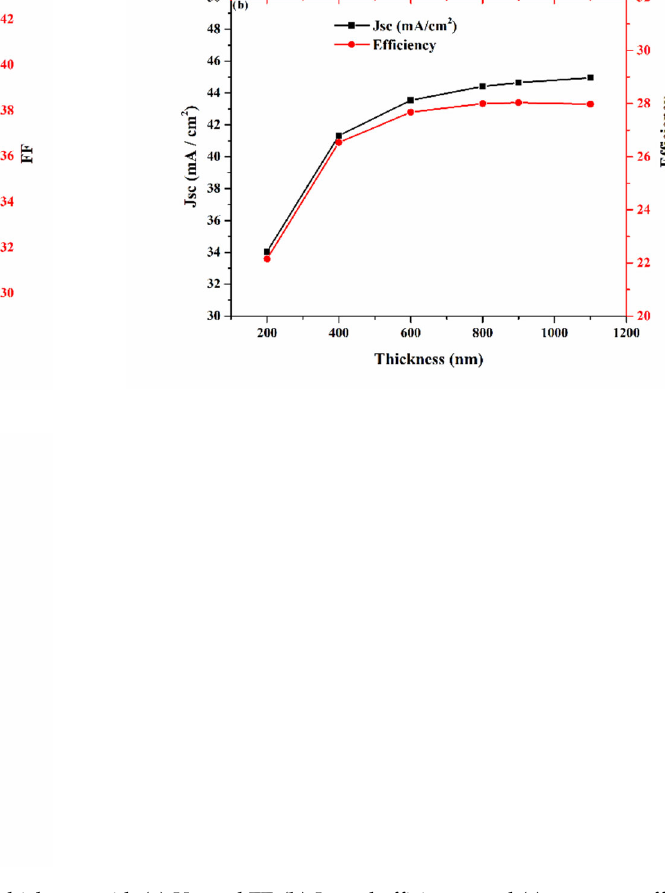
Figure 2. Absorber layer thickness with ( a ) V oc and FF, ( b ) J sc and efficiency, and ( c ) quantum effi ‐ ciency.